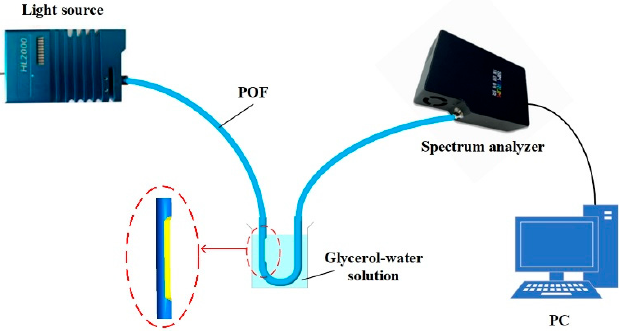
Figure 6. The schematic of experiment setup.